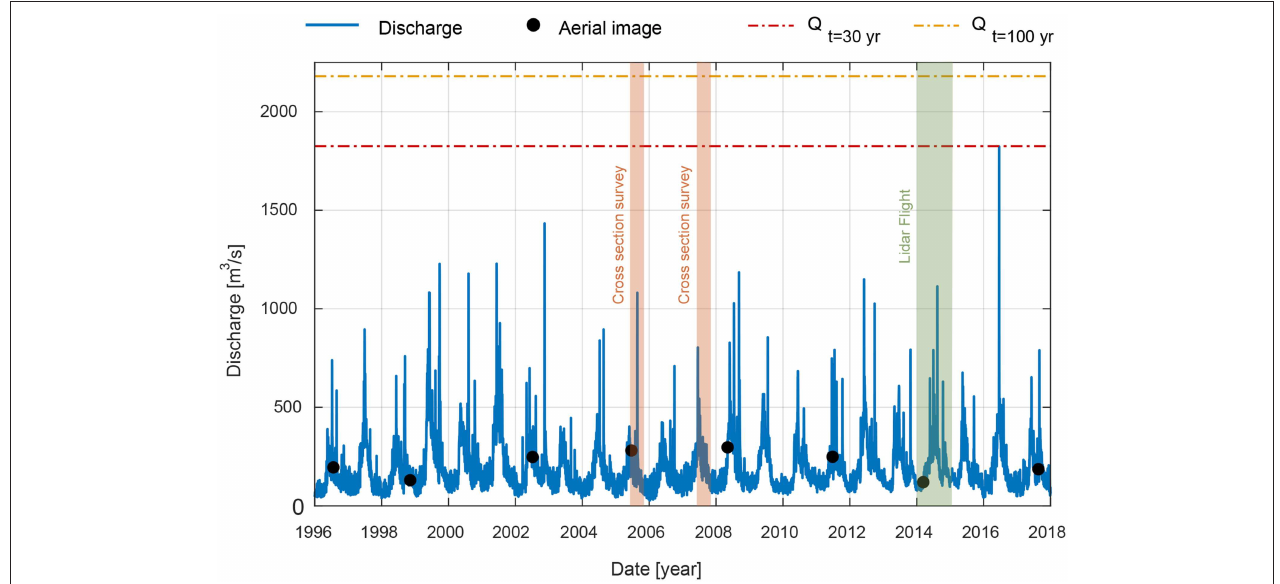
FIGURE 2 | Discharge record measured at Bangs station (Austria) between 1996 and 2017. Dashed-dotted horizontal red and orange lines indicate the discharges with a return period of 30-years ( Q t = 30 yr ) and 100-years ( Q t = 100 yr ), respectively. Black dots represent the acquisition dates of the imagery. The time span in which cross sections were surveyed and the Lidar flight (for DEM) was conducted is also